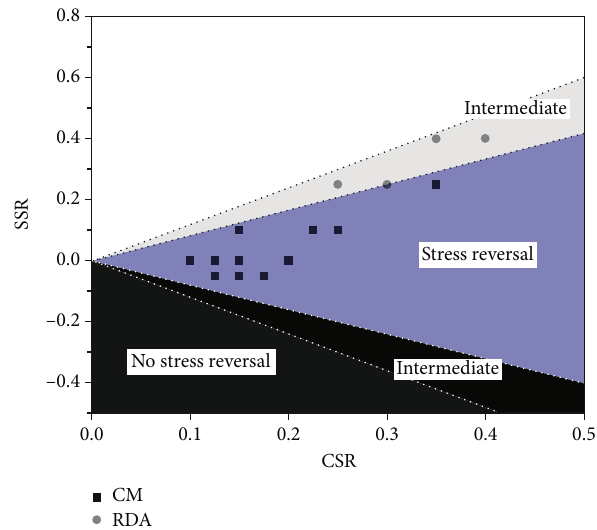
Figure 6: Summary of dense sand behavior types under di ff erent stress conditions.